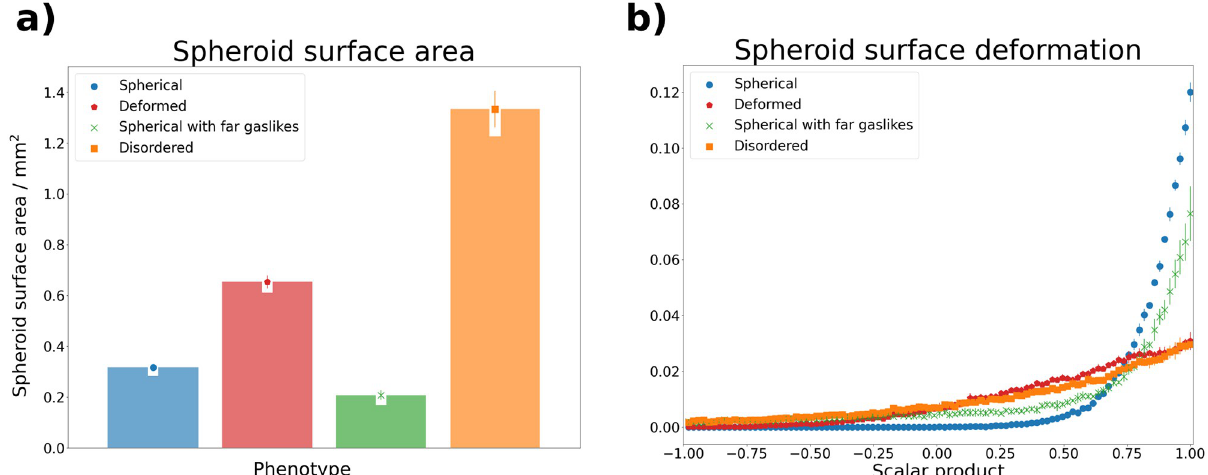
Fig 3. Visualization of spheroid bulk based features extracted from simulation data for four different phenotypes. Surface information was extracted via the marching cubes algorithm [26] (see also section 2.2). a) Spheroid surface area . Shown is the average surface area found for each phenotype. The “spherical with far gaslikes” phenotype has the smallest average surface area, due to the spherical bulk containing less cells than that of the “spherical” phenotype. The larger average surfaces of the “deformed” and “disordered” phenotypes are due to their more irregular shape. b) Spheroid surface deformation . Shown are histograms of the scalar products between vertex normal vectors and vertex origin vectors, with the origin denoting the center of the spheroid. The vertices were obtained from surface triangulation of the spheroid point cloud and denote points on this surface (see also S4 Fig). The “spherical” phenotype exhibits a sharp peak at scalar products of 1, which is less pronounced for the “spherical with far gaslikes” phenotype. The remaining two phenotypes are spread more widely.